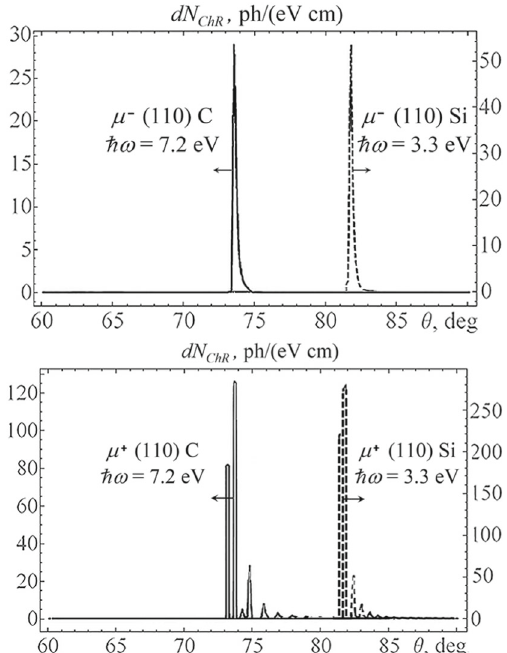
Fig. 4 ChCR angular distributions at the energies corresponding to the maximum values of G (ω) (see Fig. 2). ChCR photons are emitted by channeled 10 GeV muons ( μ − and μ + ): (right) ¯ h ω ∼ 3 . 3 eV in Si (cid:2) 81 . 4 ◦ ); (left) ¯ h ω (cid:2) 7 . 2 eV in diamond (C) ( θ max ( θ max Ch